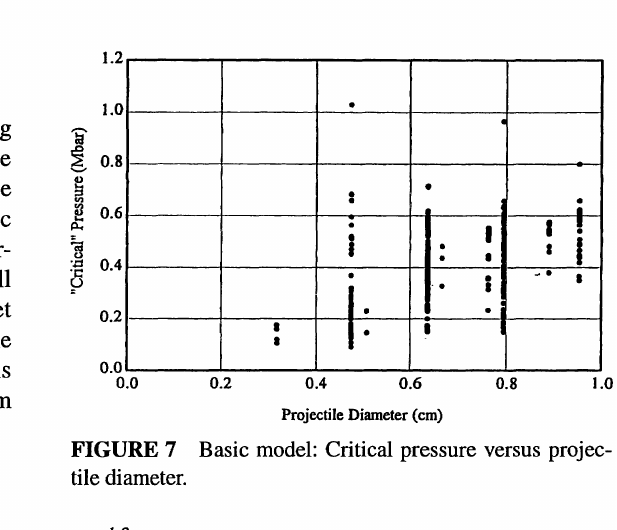
FIGURE 7 Basic model: Critical pressure versus projec tile diameter.